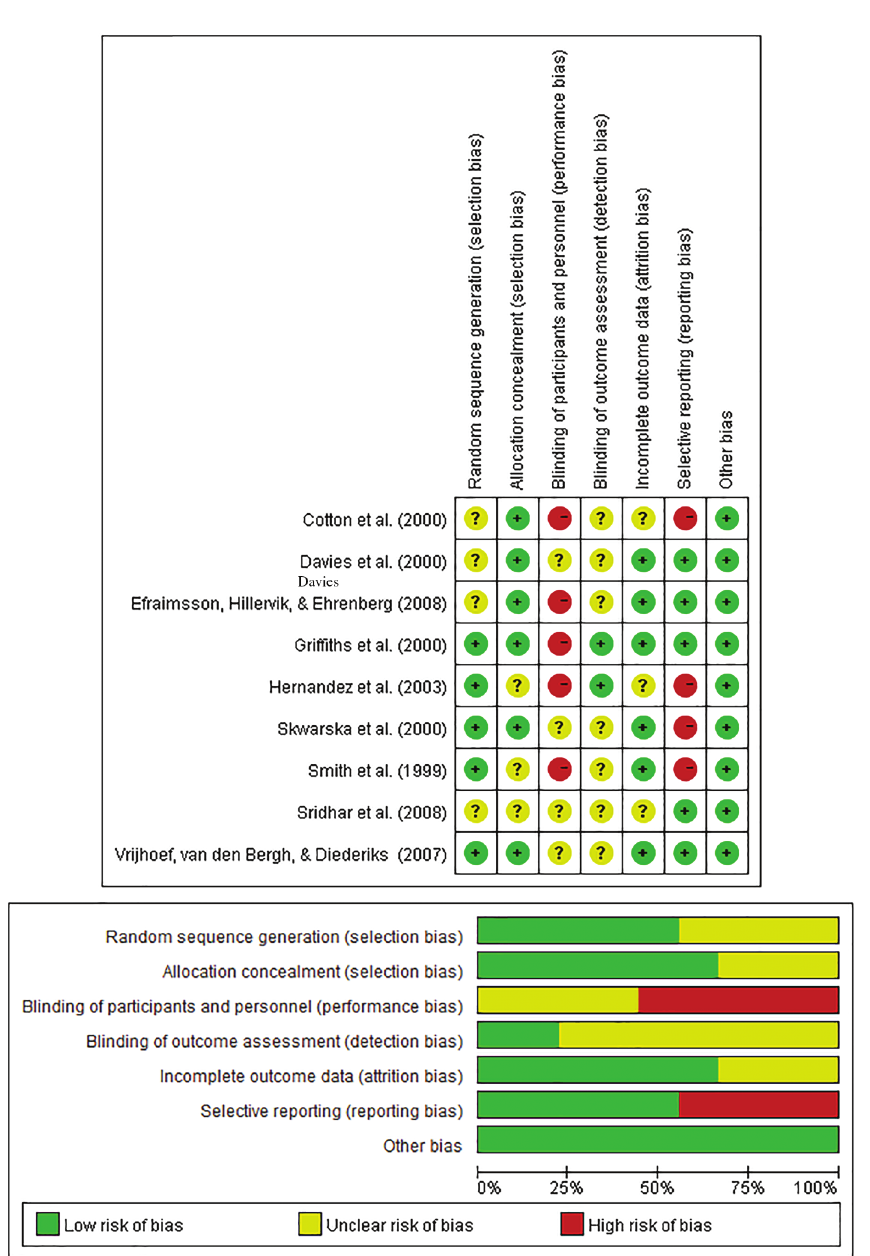
Figure 2. Summary of risk of bias for included